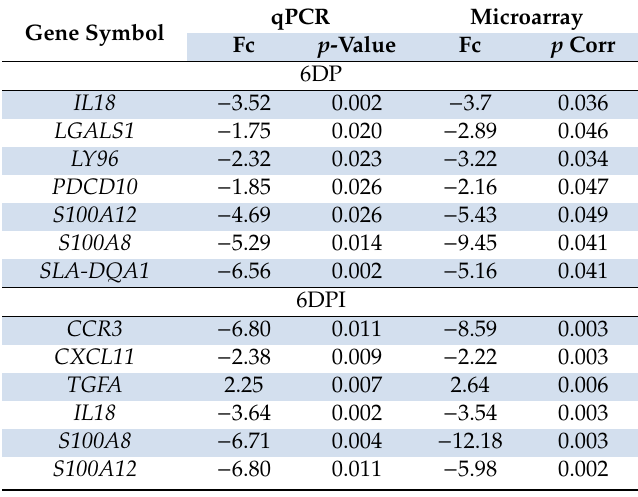
Table 2. Results of microarray experiment validation with qPCR. 6DP—6 Day of pregnancy vs. 6 Day of estrous cycle, 6DPI—6 Day after SP infusion vs. 6 Day of estrous cycle, Fc—fold